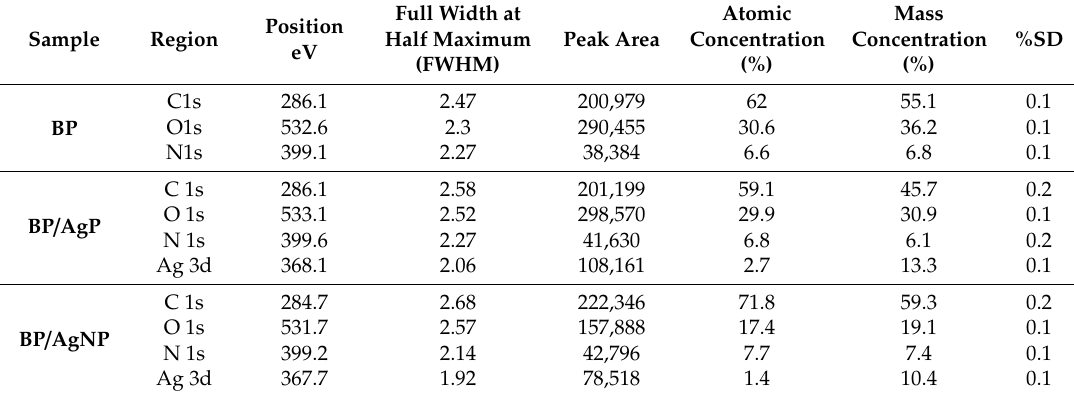
Table1. XPSresultsforBP,BP / AgP,andBP / AgNPsamples. Positionsofthemainsignalofphotoelectrons from characteristic energetic levels.